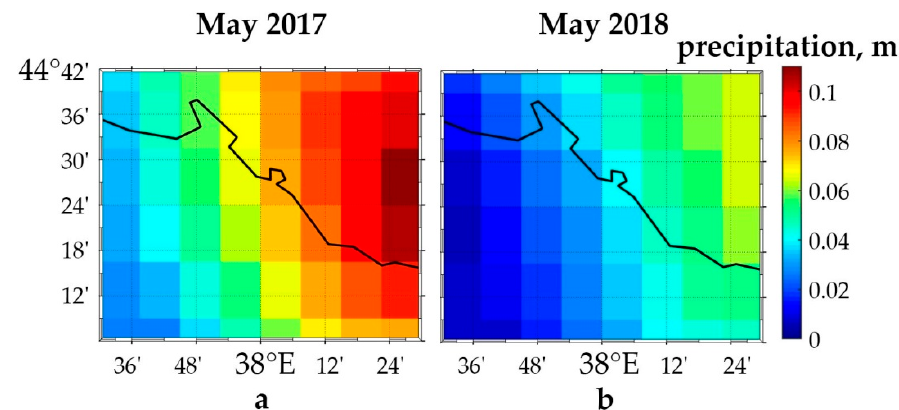
Figure 11. The daily (blue lines) and average monthly (pink bar diagrams) precipitation from 1 April to 11 June 2010–2018.